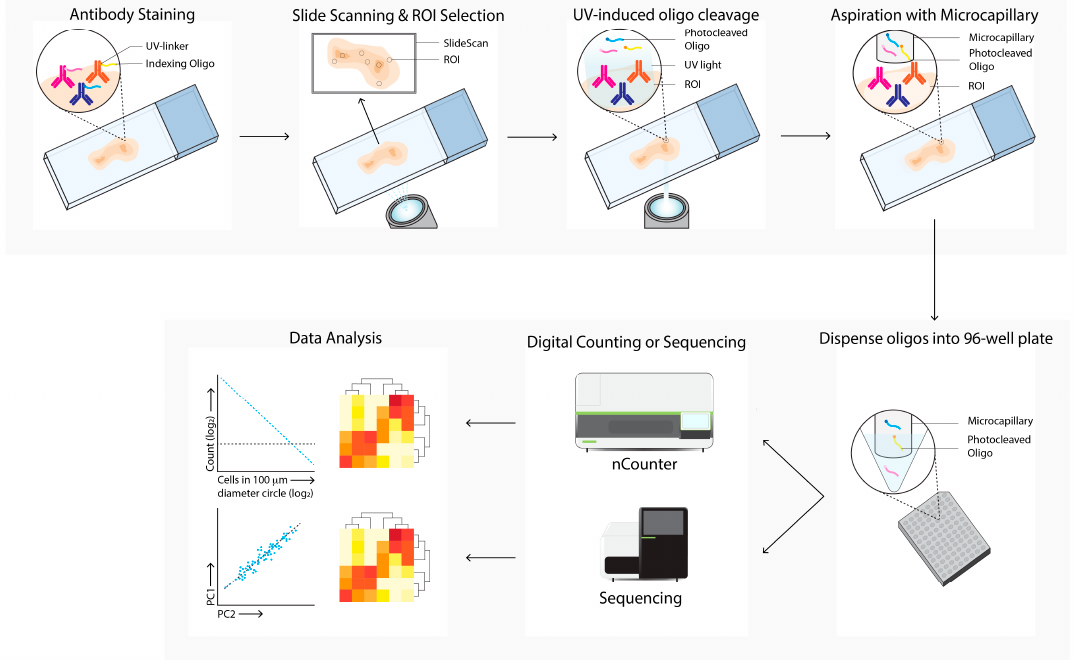
Figure 7. Digital Spatial Profiling (DSP) workflow. Tissue sections are labeled with antibodies and/or in situ hybridization with mRNA probes, which are linked with UV-cleavable oligo-tags. Slides are labeled with fluorescence-conjugated antibodies to determine cell subsets and select regions of interests and masks for bulk cell subsets for directed UV-cleavage of the oligo-tags. The cleaved oligos are collected with a microcapillary and transferred to a 96-well plate. Next, the oligos are quantified by digital counting (nCounter) or next-generation sequencing. Differential expression of specific mRNA or proteins between ROIs and cell subsets are next analyzed (data